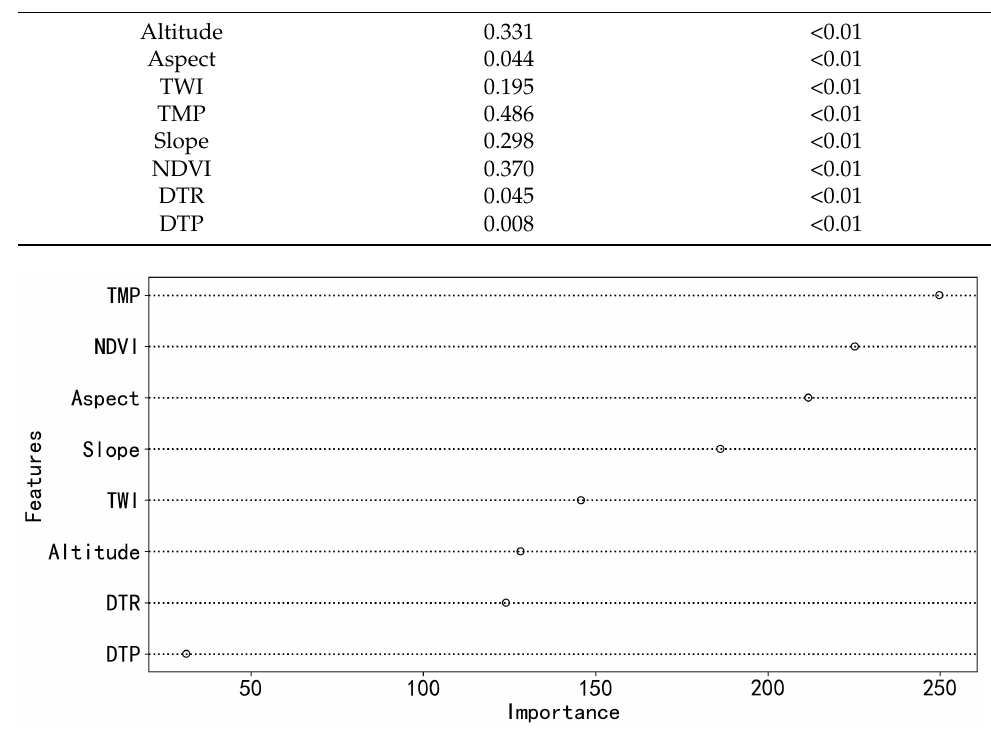
Figure 6. The importance of forest fire-influencing